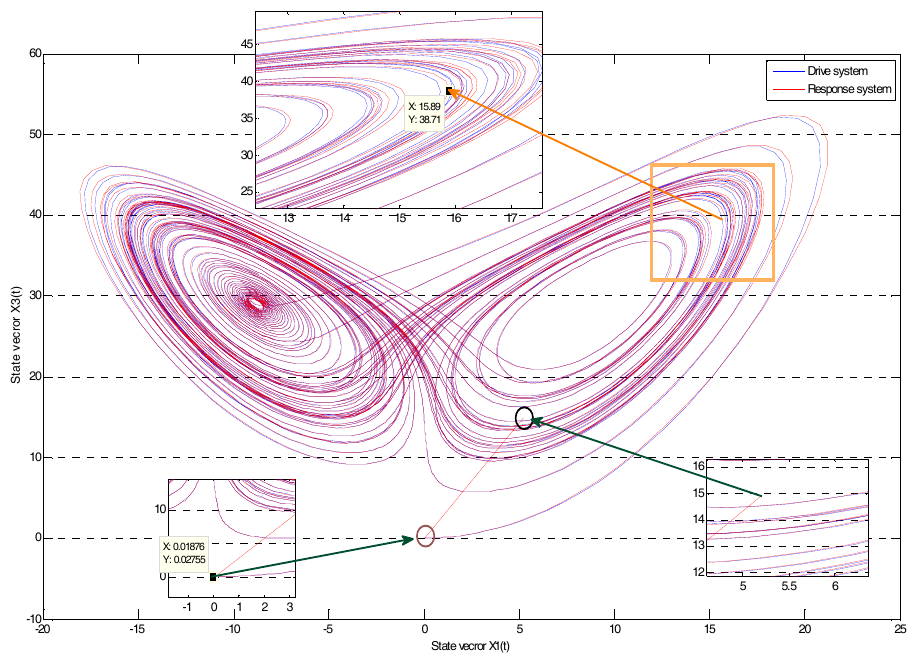
Figure 2. The trajectories in two-dimensional x1, x3-space of systems.